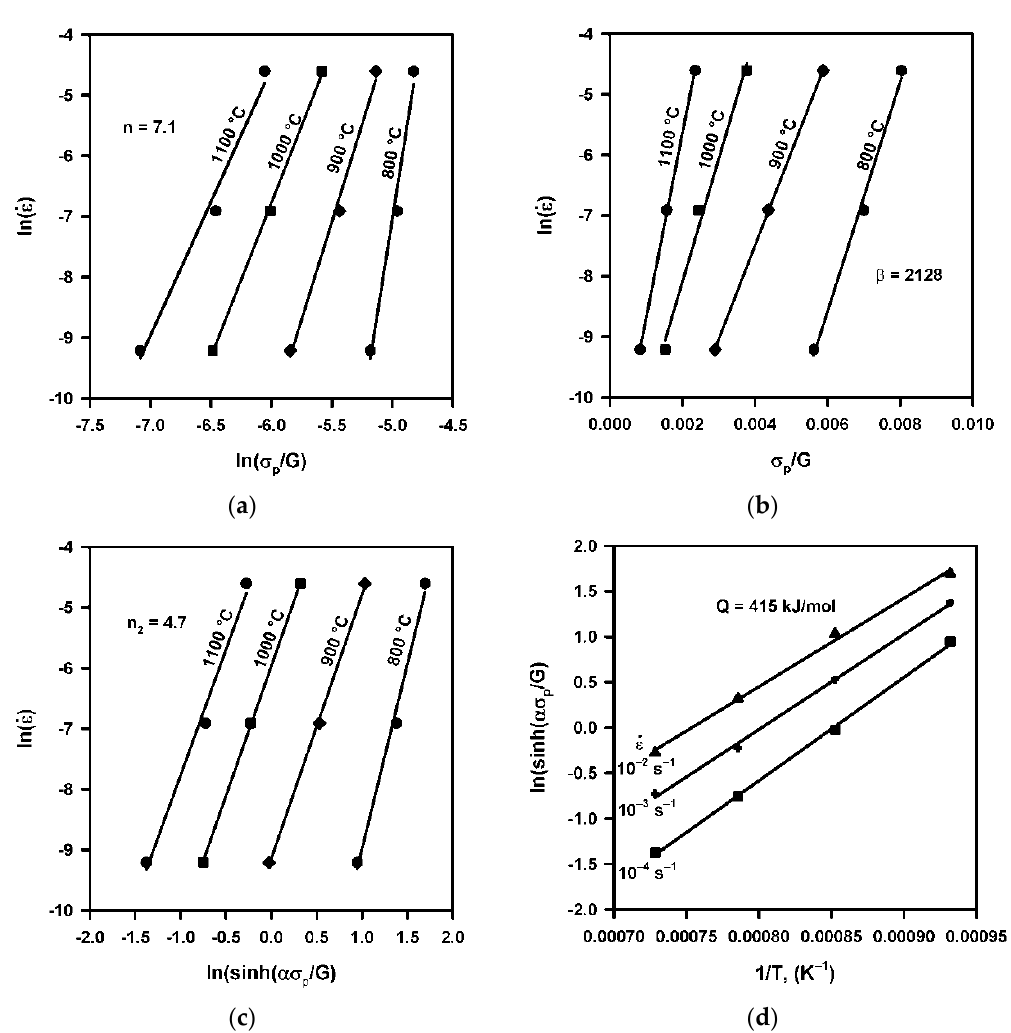
Figure 4. Relationships between strain rate and peak flow stress according to Equation (1) ( a ), Equation (2) ( b ), Equation (3) ( c ), and ln(sinh( ασ P /G)) vs. 1/T ( d ) for hot compression of a highly-alloyed austenitic stainless steel.